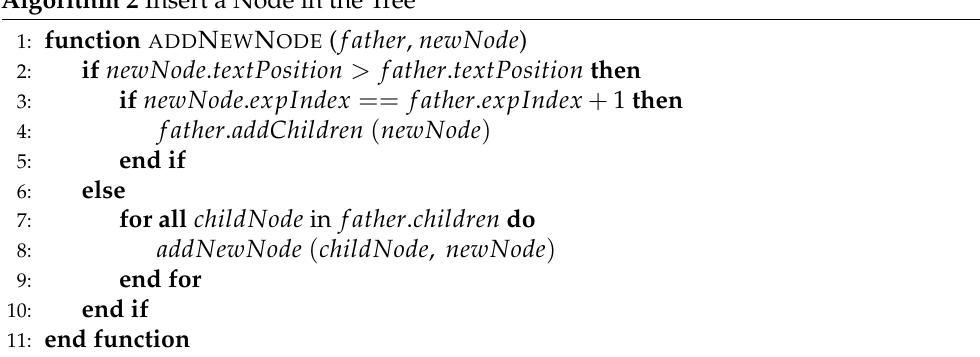
Algorithm 2 Insert a Node in the Tree